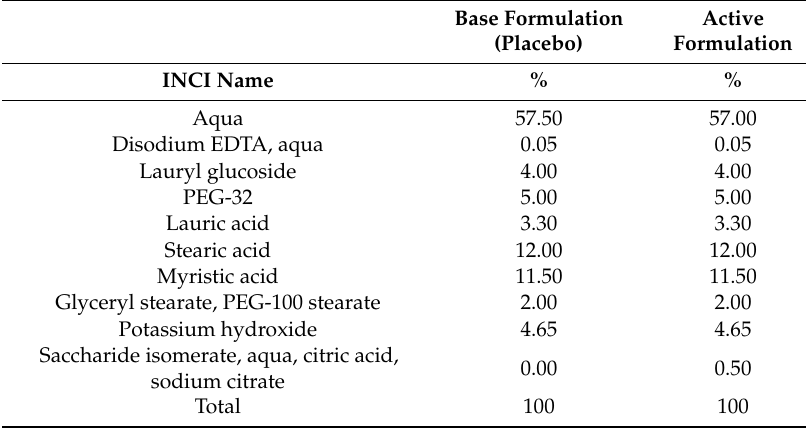
Table 1. Formulations used in the clinical